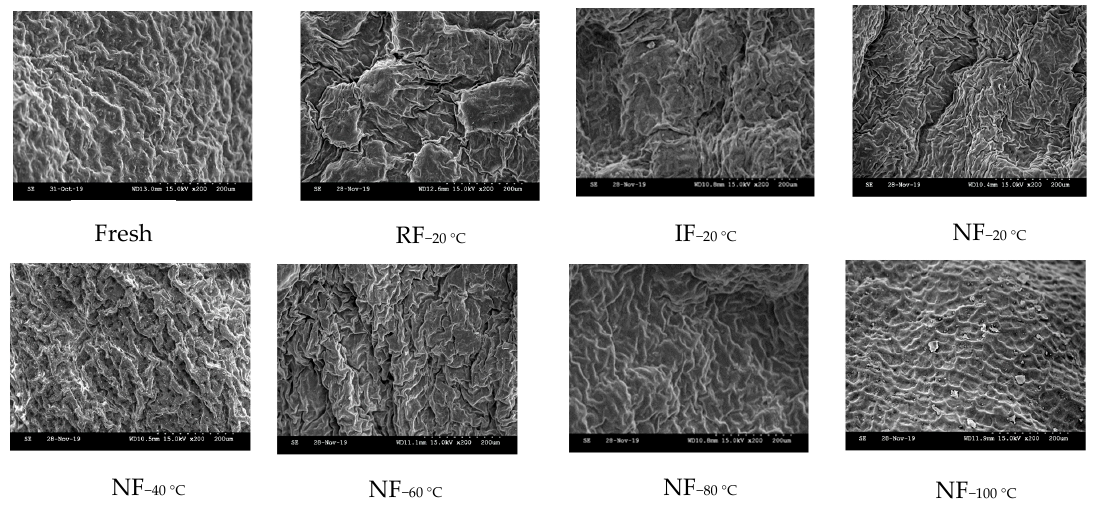
Figure 4. Microstructure changes of thawed blueberries treated by different freezing methods.